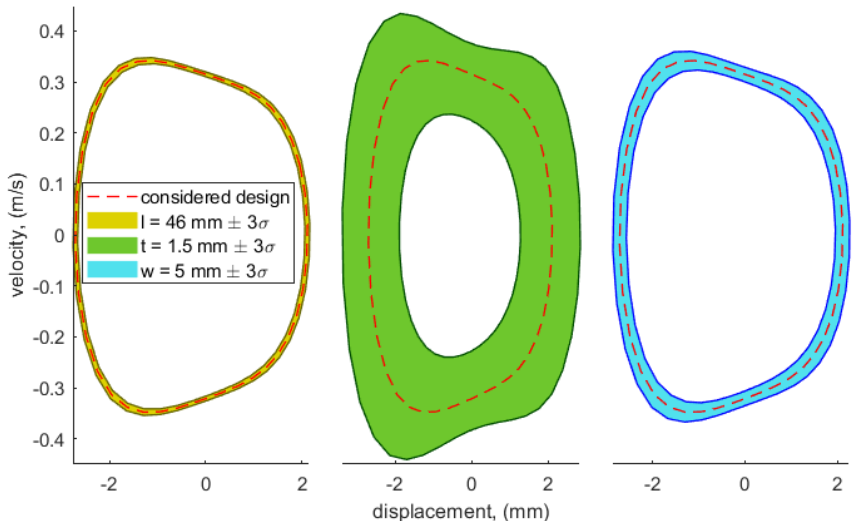
Figure 5. Poincare maps of the centre of mass of a vibrating yoke obtained for three border values of l , t and w (see Table 2). The results are obtained from model (20) for sinusoidal acceleration with a RMS = 12.5 m/s 2 and frequency equal to 25 Hz.